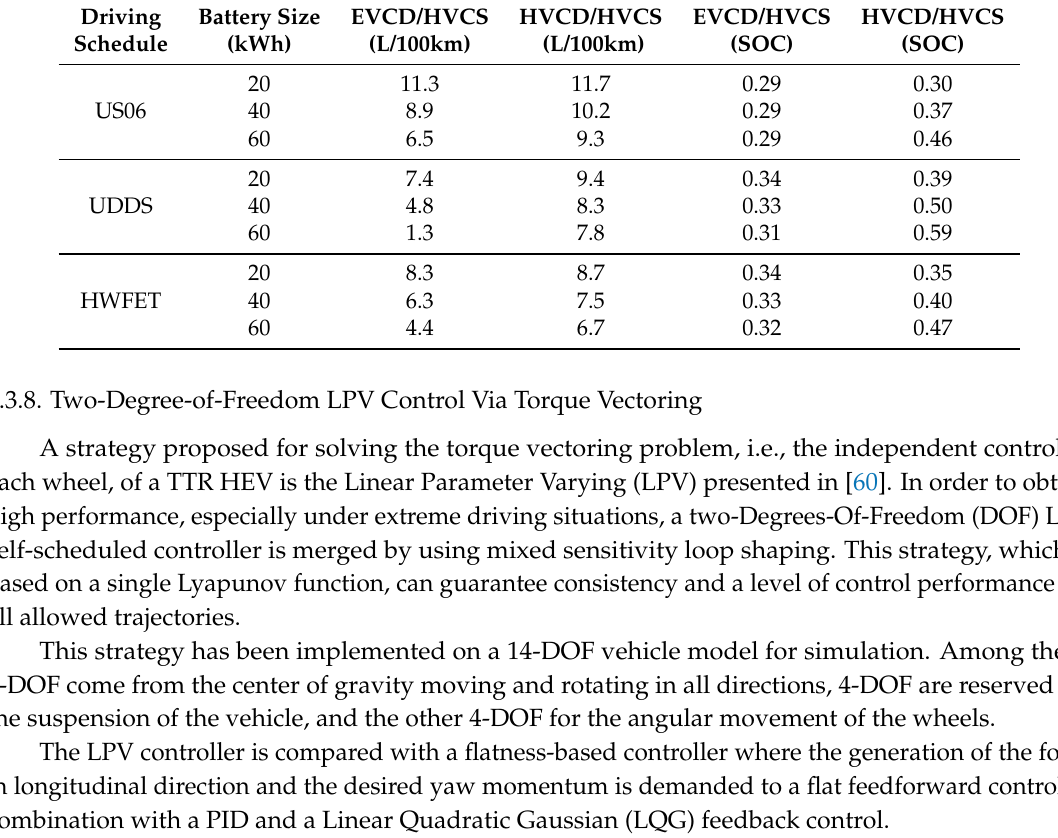
Table 13. Comparison of fuel consumption and final SOC between strategies EVCD/HVCS and HVCD/HVCS for three battery sizes at the end of 16 cycles of each of the three driving schedules [58].